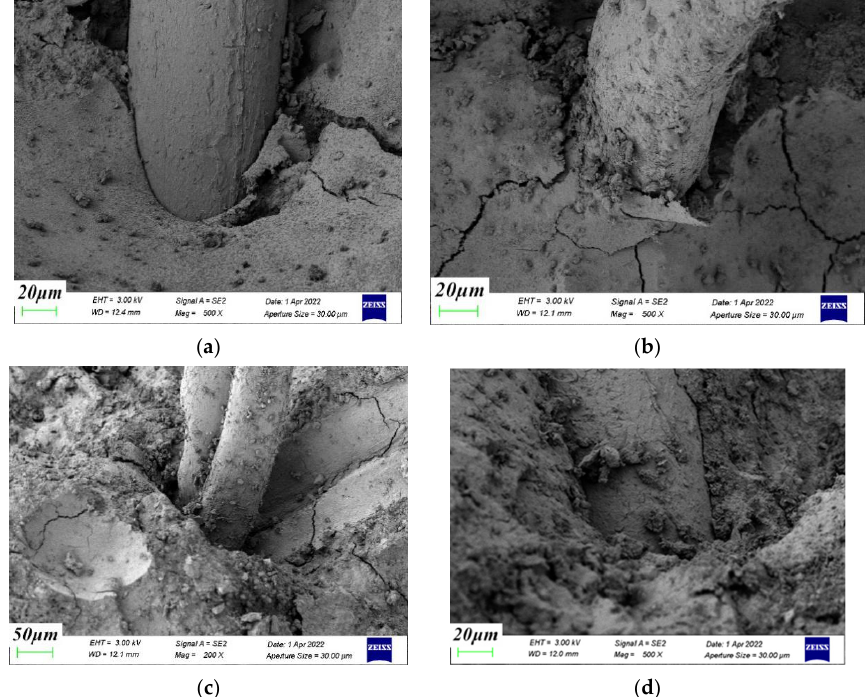
Figure 15. Fiber–cement paste interface transition zone. ( a ) 0 MPa, ( b ) 6 MPa, ( c ) 12 MPa, ( d ) 18 MPa.